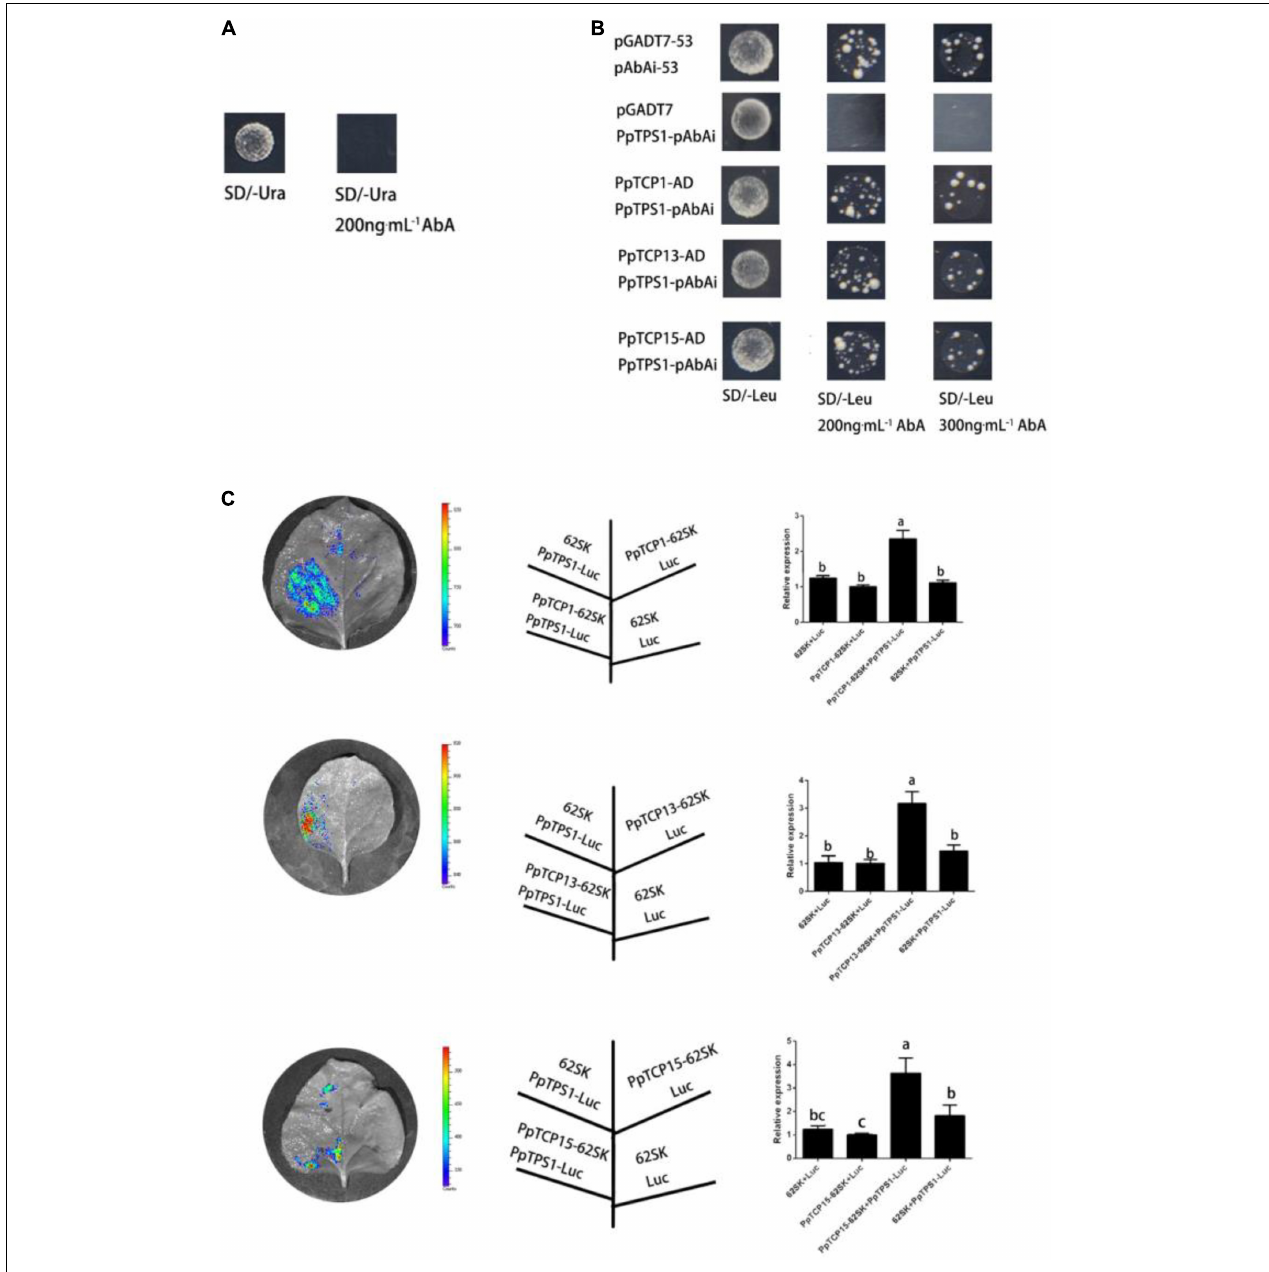
FIGURE 5 | PpTCP1 , PpTCP13 , and PpTCP15 can activate the expression of PpTPS1 . (A) The PpTPS1-pAbAi “bait” strain was inhibited by 200 ng · mL − 1 AbA. (B) The PpTCP1-pGADT7, PpTCP13-pGADT7, and PpTCP15-pGADT7 plasmids were constructed, transformed into Y1H medium containing PpTPS1 100 − 400 -pAbAi, and cultured in Leu medium at 30 ◦ C in the dark for 3 days. The grown yeast was then diluted with 0.9% NaCl solution (OD600 = 0.002), spotted on SD/-Leu at concentrations of 200 and 300 ng · mL − 1 AbA, and cultured in the dark at 30 ◦ C for 3–5 days. (C) A tobacco dual-luciferase experiment verified that PpTCP1 , PpTCP13 , and PpTCP15 could activate the expression of PpTPS1 . Biological triplicates were performed for each sample. Different letters represent significant differences according to ANOVA and Duncan’s test ( P <